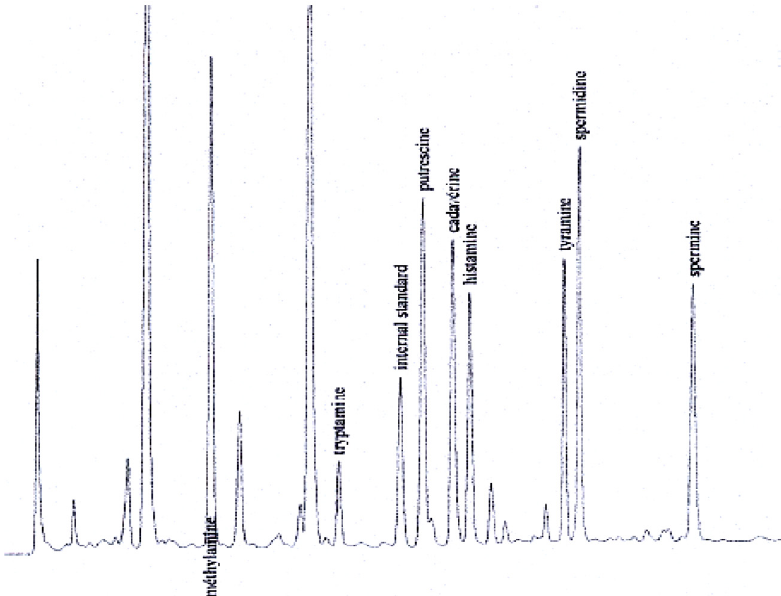
Fig. 1. Reference chromatogram (Duflos et al.